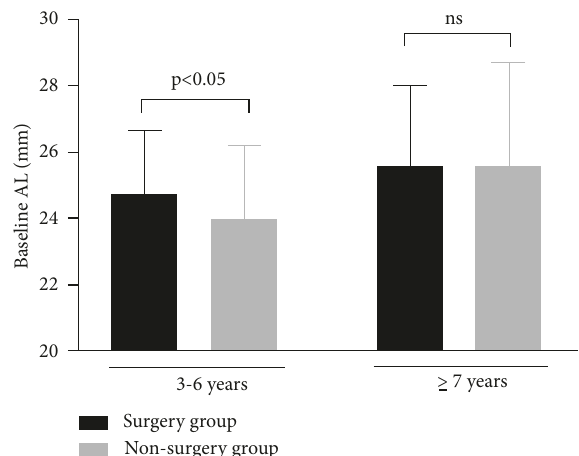
Figure 2: Comparison of the baseline axial length in the surgery group and the nonsurgery group of CEL